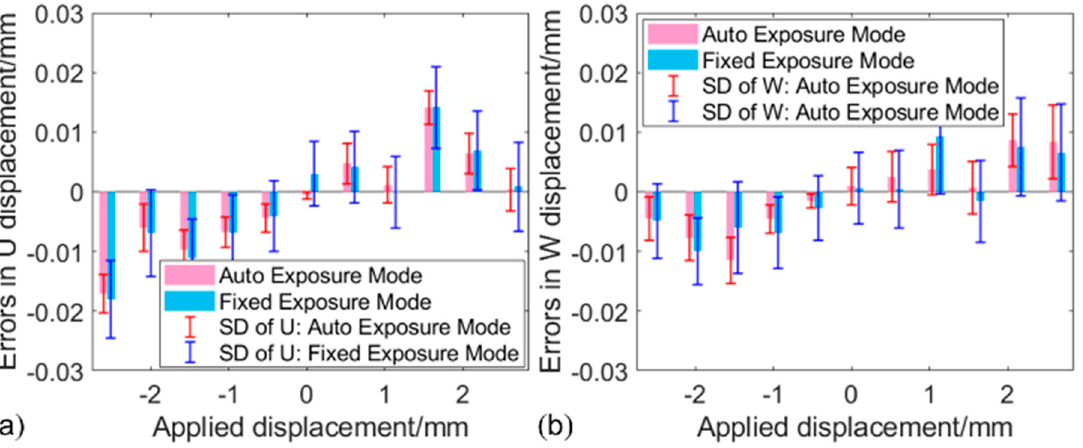
Figure 8. ( a ) U displacement errors along translation direction in the in − plane translation tests; ( b ) W displacement errors along translation direction in the out − of − plane translation tests.